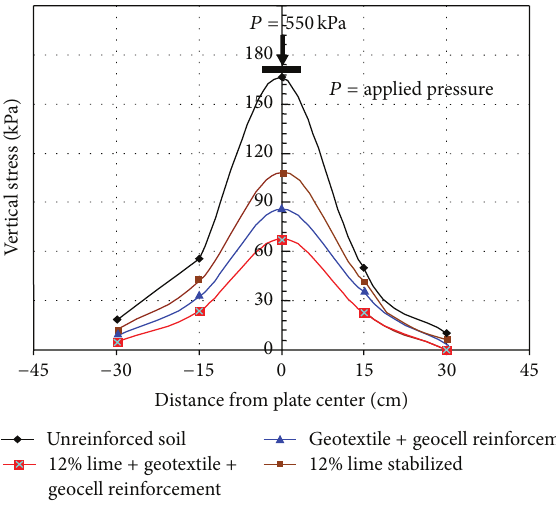
Figure 9: The vertical stress values on